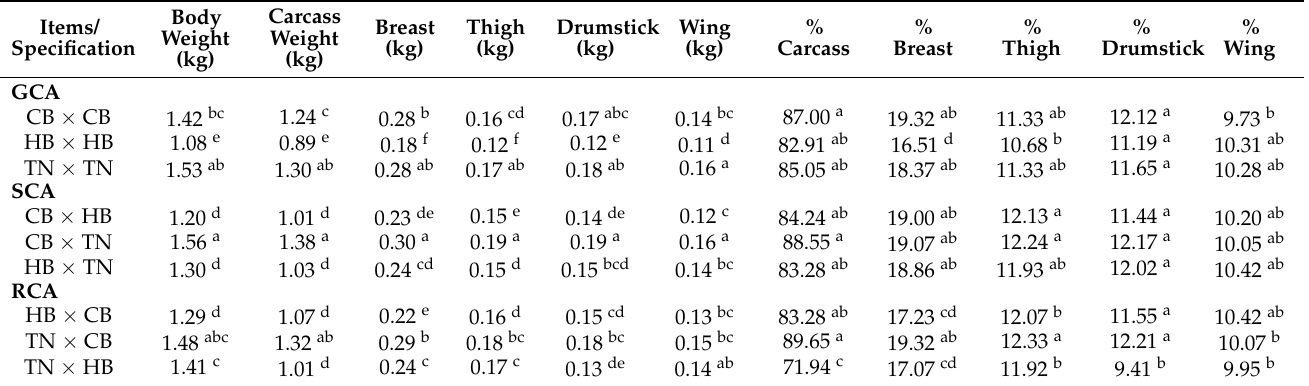
Table 3. The carcass weight and carcass percentage of black-bone chickens, Thai native chickens, and their crossbreds.